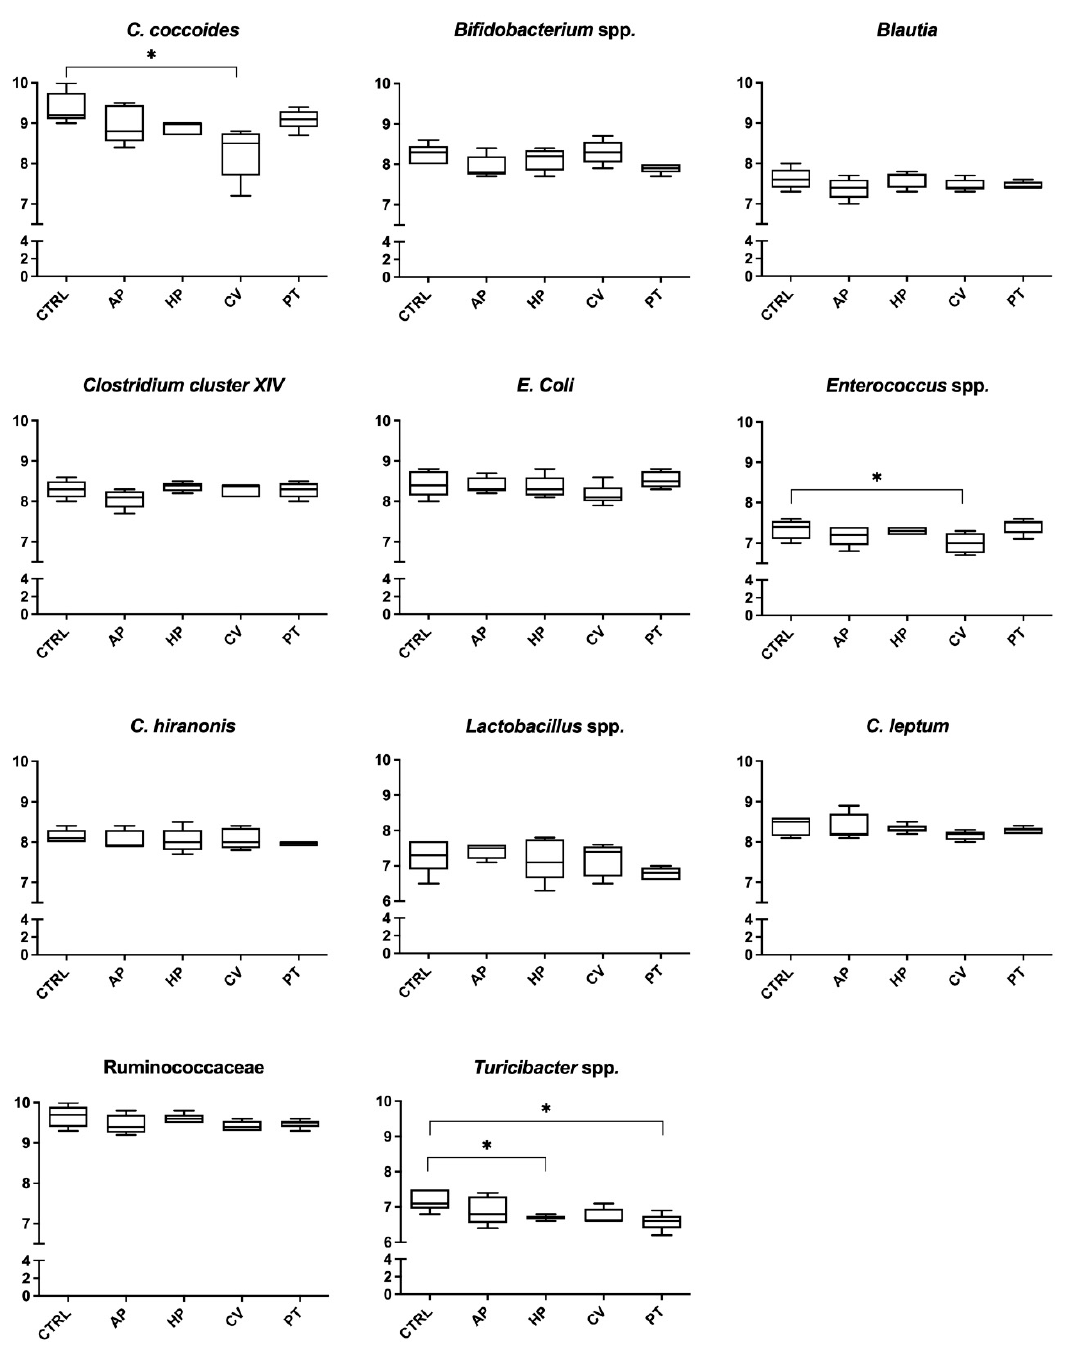
Figure 2. Microbial analysis (log 10 copies DNA/75 ng DNA) after 24 h of an in vitro incubation of canine fecal inoculum with a control diet supplemented with microalgae. Values are the means of five bottles per treatment. CTRL, control; AP, Arthrospira platensis ; HP, Haematococcus pluvialis ; CV, Chlorella vulgaris ; PT, Phaeodactylum tricornutum . * p < 0.05.